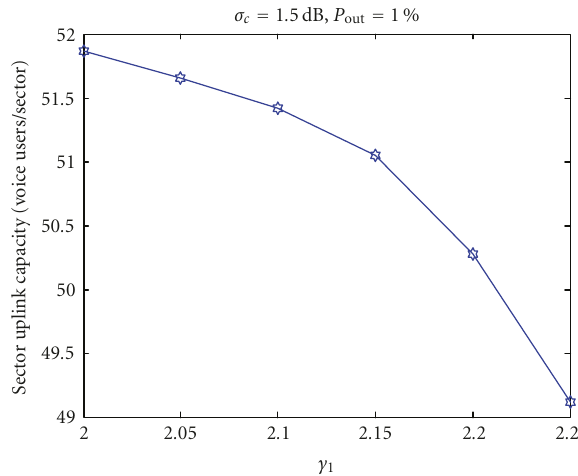
Figure 10: E ff ect of the break point distance R b on the sector uplink capacity.